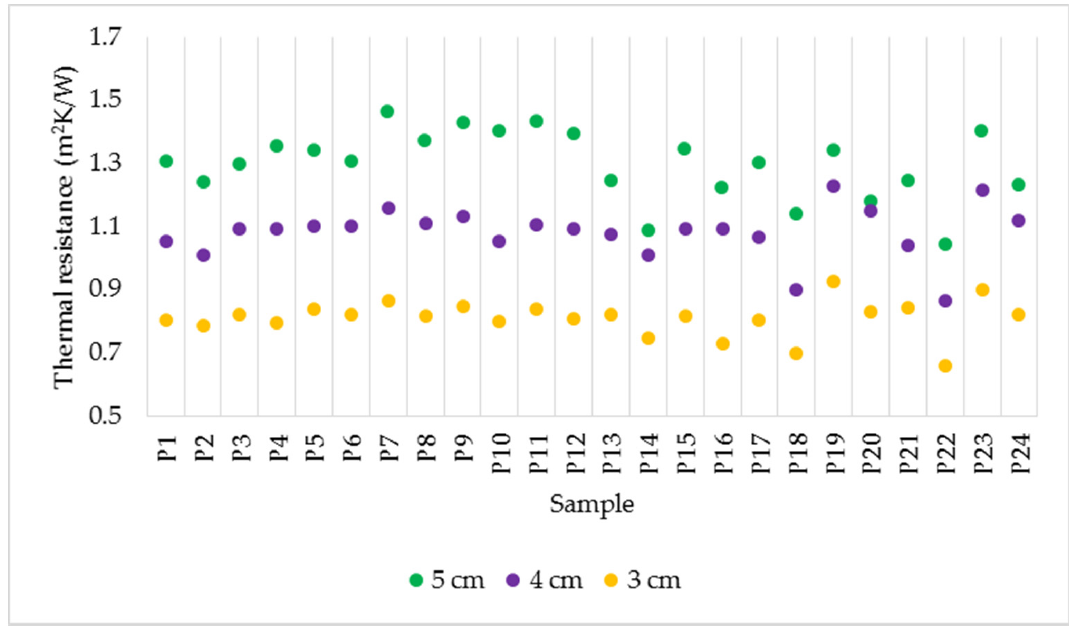
Figure 8. Variation of thermal resistance for the samples with thicknesses of 5, 4 and 3 cm.